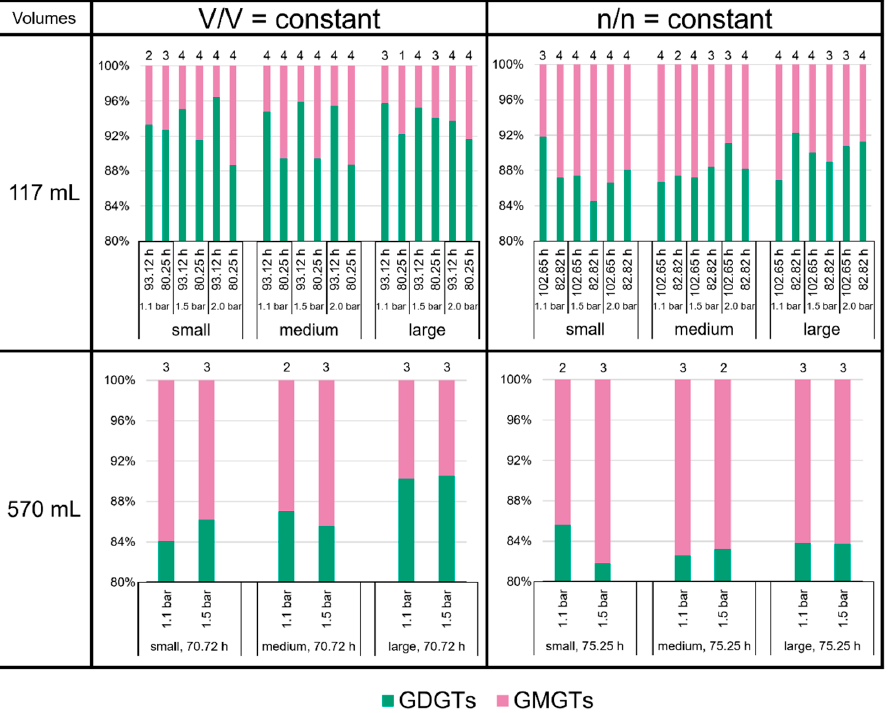
Figure 6. Tetraether lipid (GDGTs and GMGTs) ratios in M. marburgensis cultures in %. Pressure is given in bar relative to atmospheric pressure. Numbers above bars indicate number of samples. Samples quantified with 5- α -cholestane standard are indicated in Tables S4–S9.